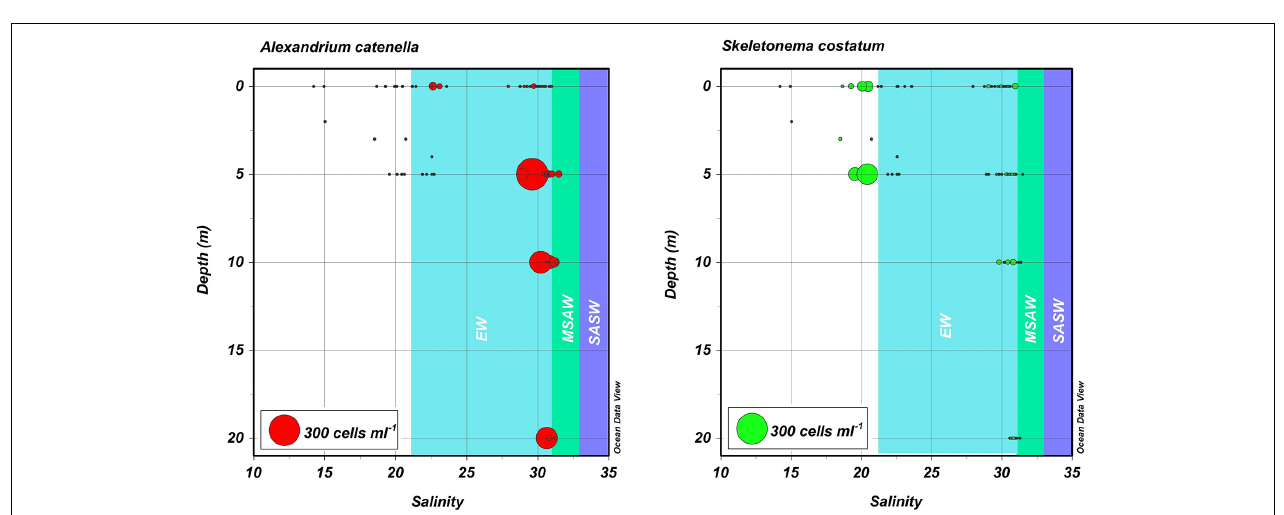
FIGURE 5 | Depth, salinity, abundance plots for blooms of A. catenella in Magallanes and Tierra del Fuego regions in 1972 and 1981. Hydrographic and cell abundance data were taken from the area ( Figures 1 , 2 ) centering on Bahia Bell, Clarence Island in 1972 (Guzmán et al., 1975a; Guzmán and Lembeye, 1975; Lembeye et al., 1975) and from Seno Union, 1981 (Lembeye, 1981a,b). Circles represent abundance of the dinoflagellate A. catenella (left) and the diatom S. costatum (right). Shaded areas are a schematic representation of the approximate salinity ranges of subantartic surface water (SASW; ∼ 33–34.6), modified subantarctic water (MSAW; ∼ 31–33), and estuarine water (EW; ∼ 21–31) according to Sievers and Silva